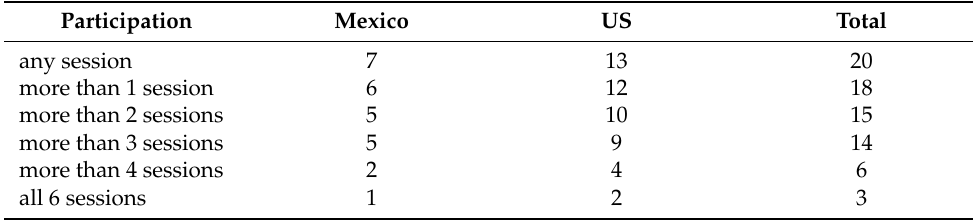
Table 6. Summary of participation in the